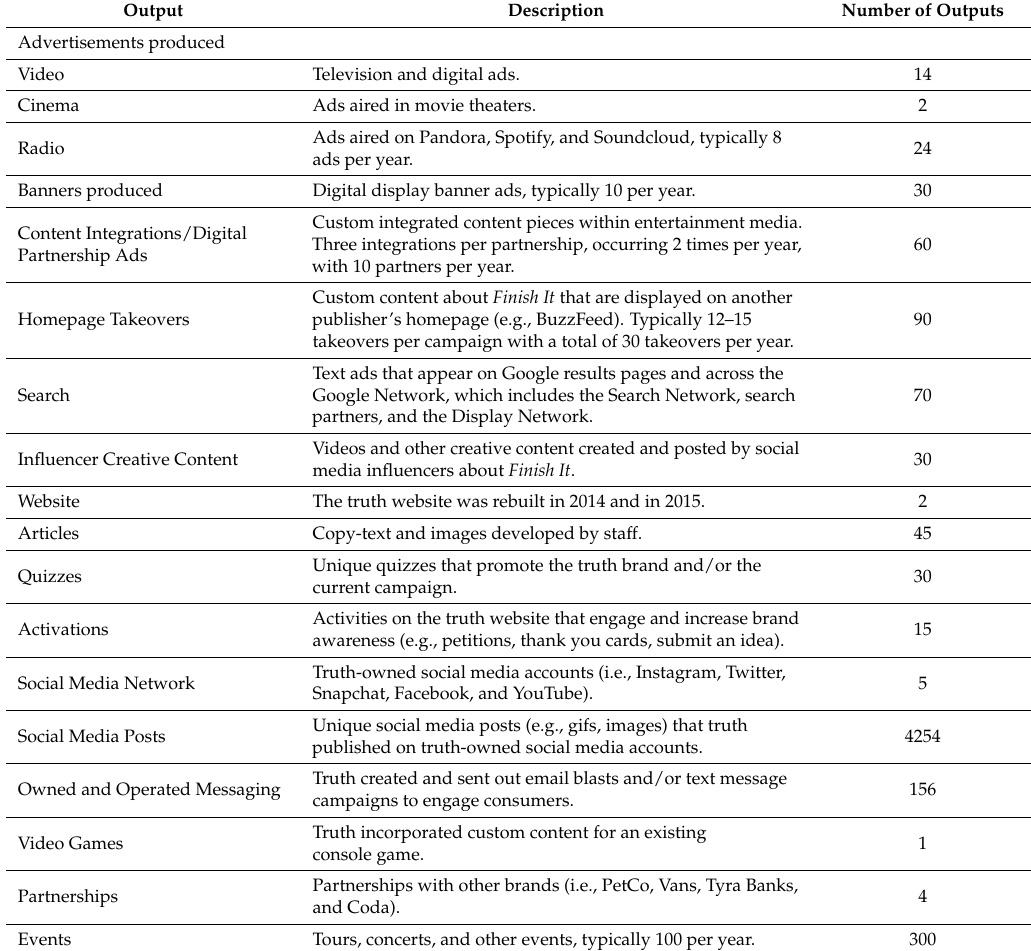
Table 1. Direct outputs of the FinishIt campaign